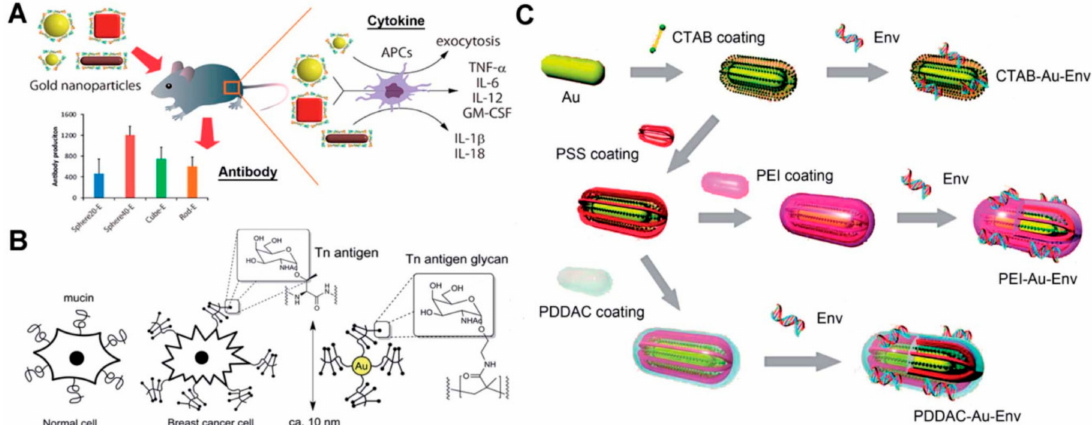
Figure 51. Schematic representation as synthetic vaccines of the different antigen conjugated Au NPs. ( A ) an antigen-based West Nile virus protein (WNVE) attached to PSS-MA coated Au NP (different sizes and forms) through electrostatic activity directed to virus vaccinations. Copyright 2013 ACS, reproduced with reference permission [348], ( B ) Tn antigen glycopolymer antigen, covalently modified in Au NPs for cancer vaccines, associated mucinal cells. With reference authorization [366], 2013 ACS Copyright. ( C ) HIV-1 Env plasmid DNA as an antigen attached to surface rods such as Au NPs for virus vaccines (coated with different polymers). Copyright 2012, ACS, reproduced with reference permission [367], Copyright 2012,